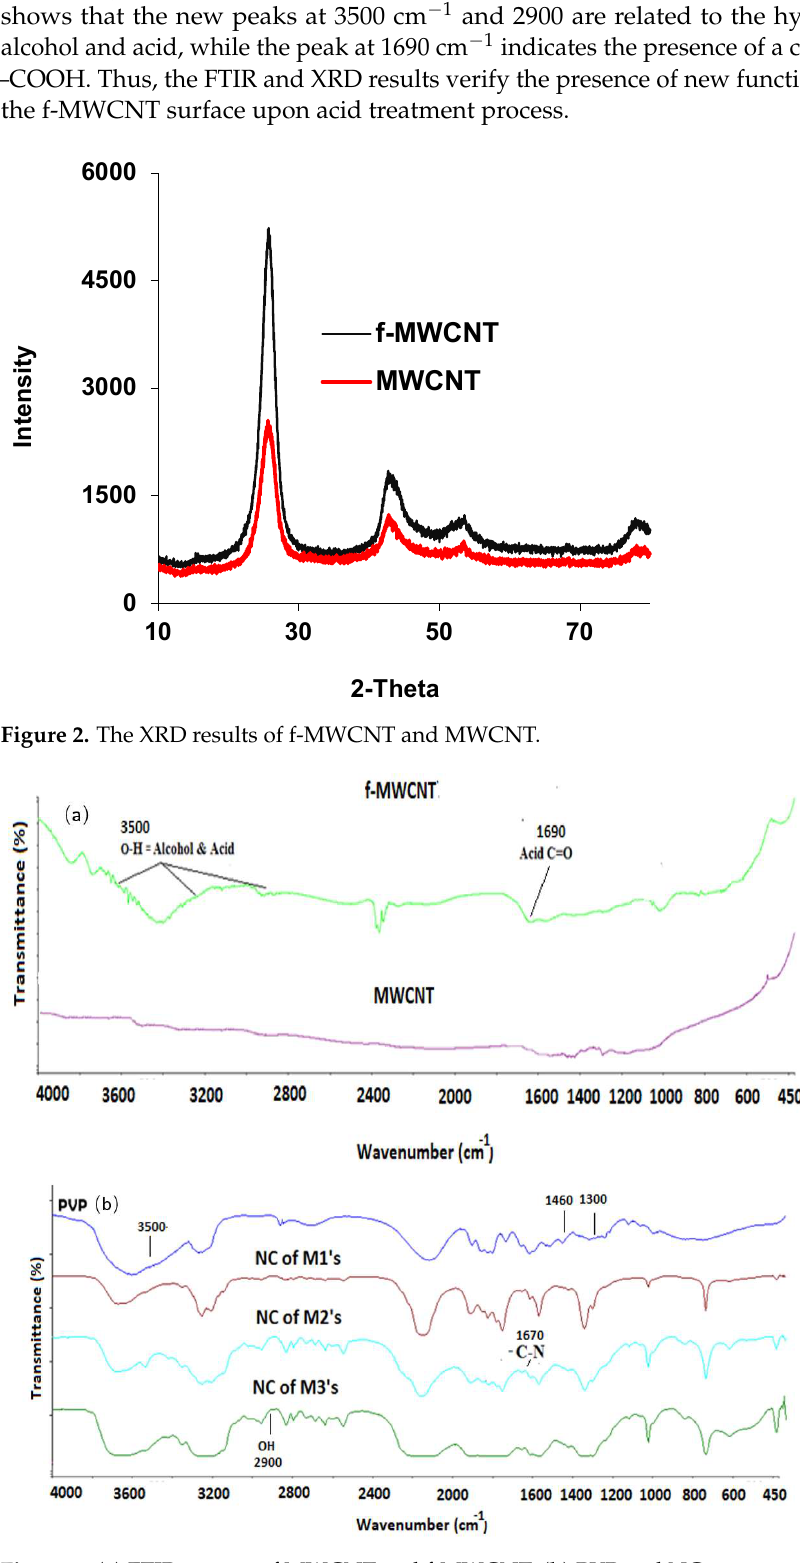
Figure 3. ( a ) FTIR spectra of MWCNT and f-MWCNT, ( b ) PVP and